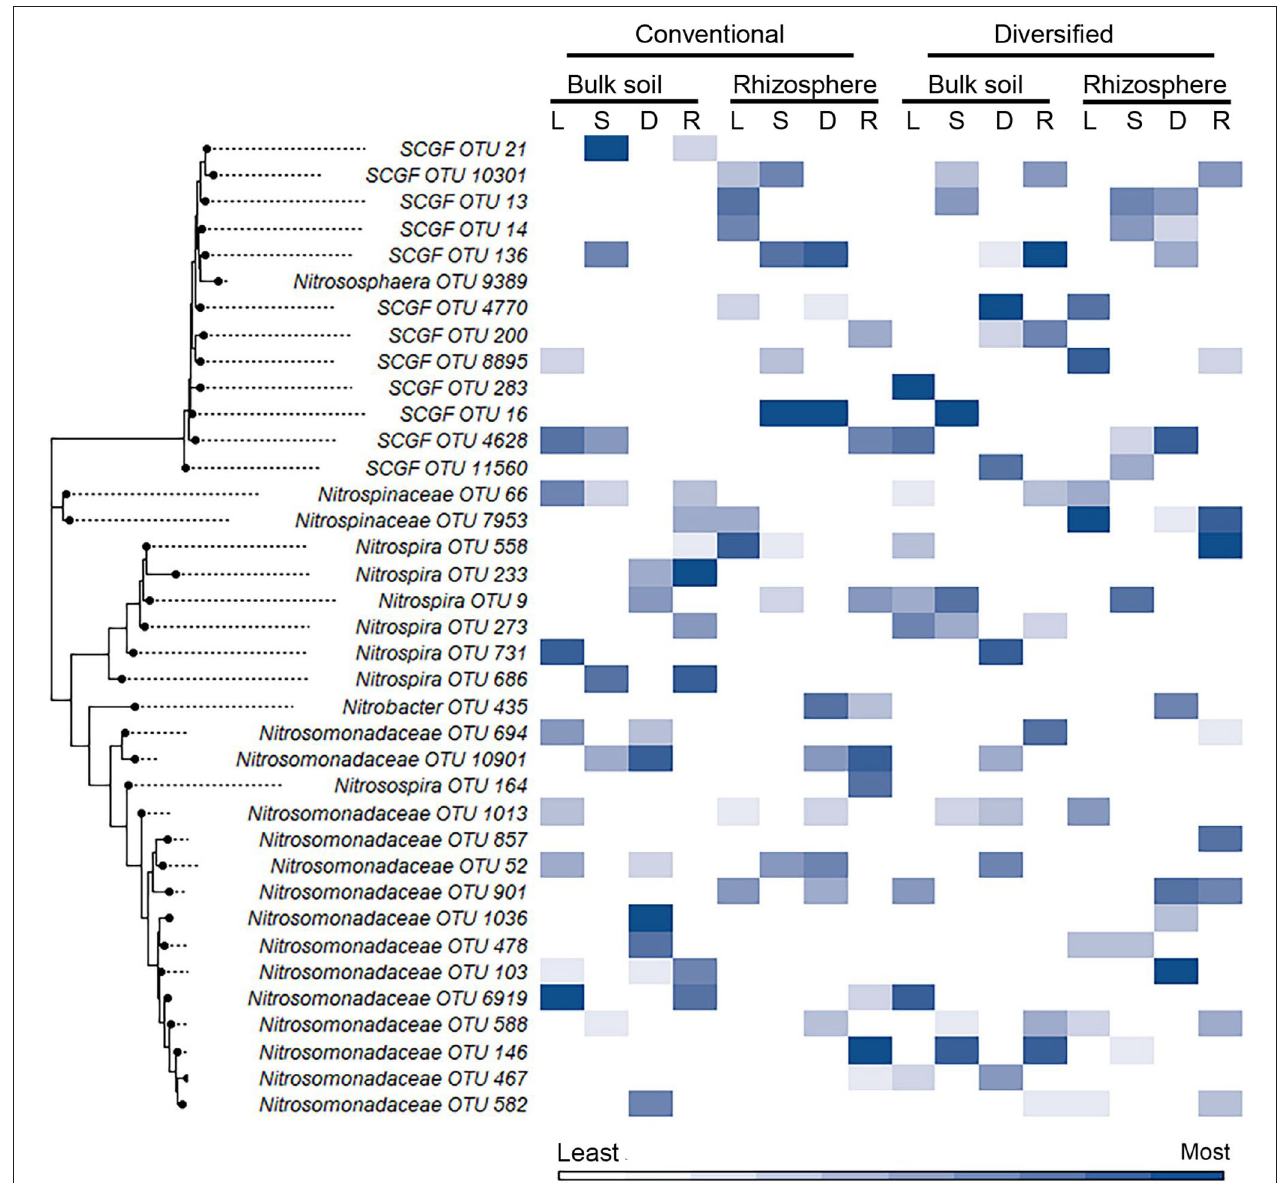
FIGURE 3 | Heat map of importance of specific OTU’s in linear and nonlinear models for each cropping system by habitat. OTU 16S V4 sequences were aligned using ClustalW in MEGA11, and the trees were generated using the maximum likelihood method with default parameters. Heat map color (within a column) reflects importance of the top 10 OTUs: white reflects OTUs ranked 10th or below in model importance (linear regression: L; support vector machine: S; decision tree: D; random forest: R). SCGF, soil crenarchaeotic group